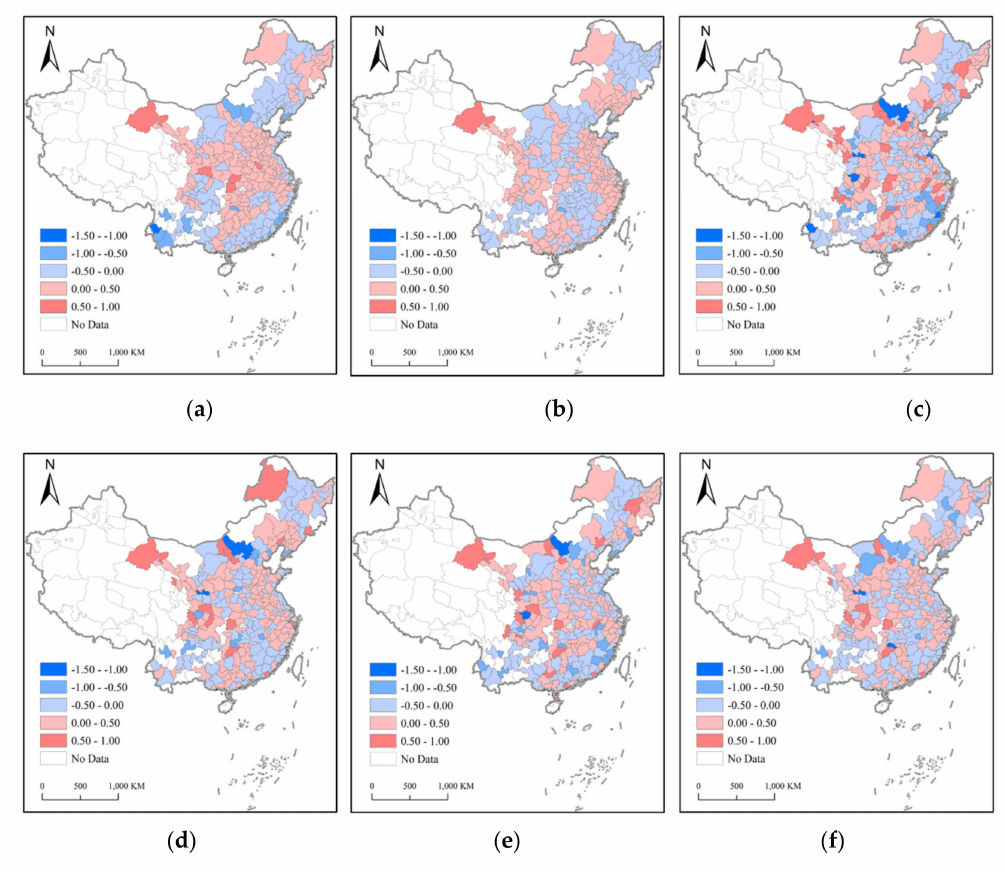
Figure 7. Spatial distribution of residuals in December 2017: ( a ) OLS; ( b ) OLSL; ( c ) GWR; ( d ) GWRL; ( e ) MGWR; ( f )